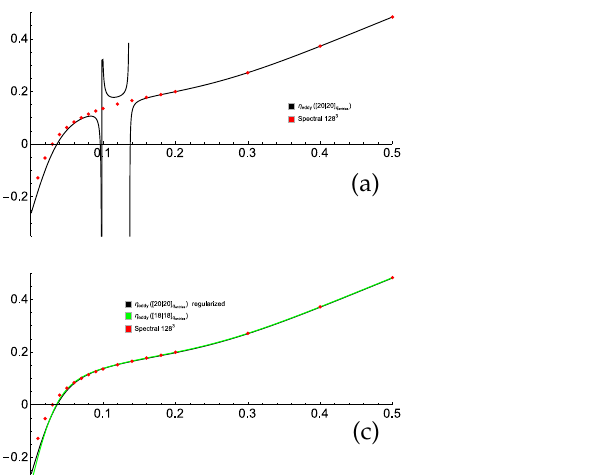
Figure 4. The ratios independent entries of the eddy diffusivity tensor for the cosine flow (49), (51).